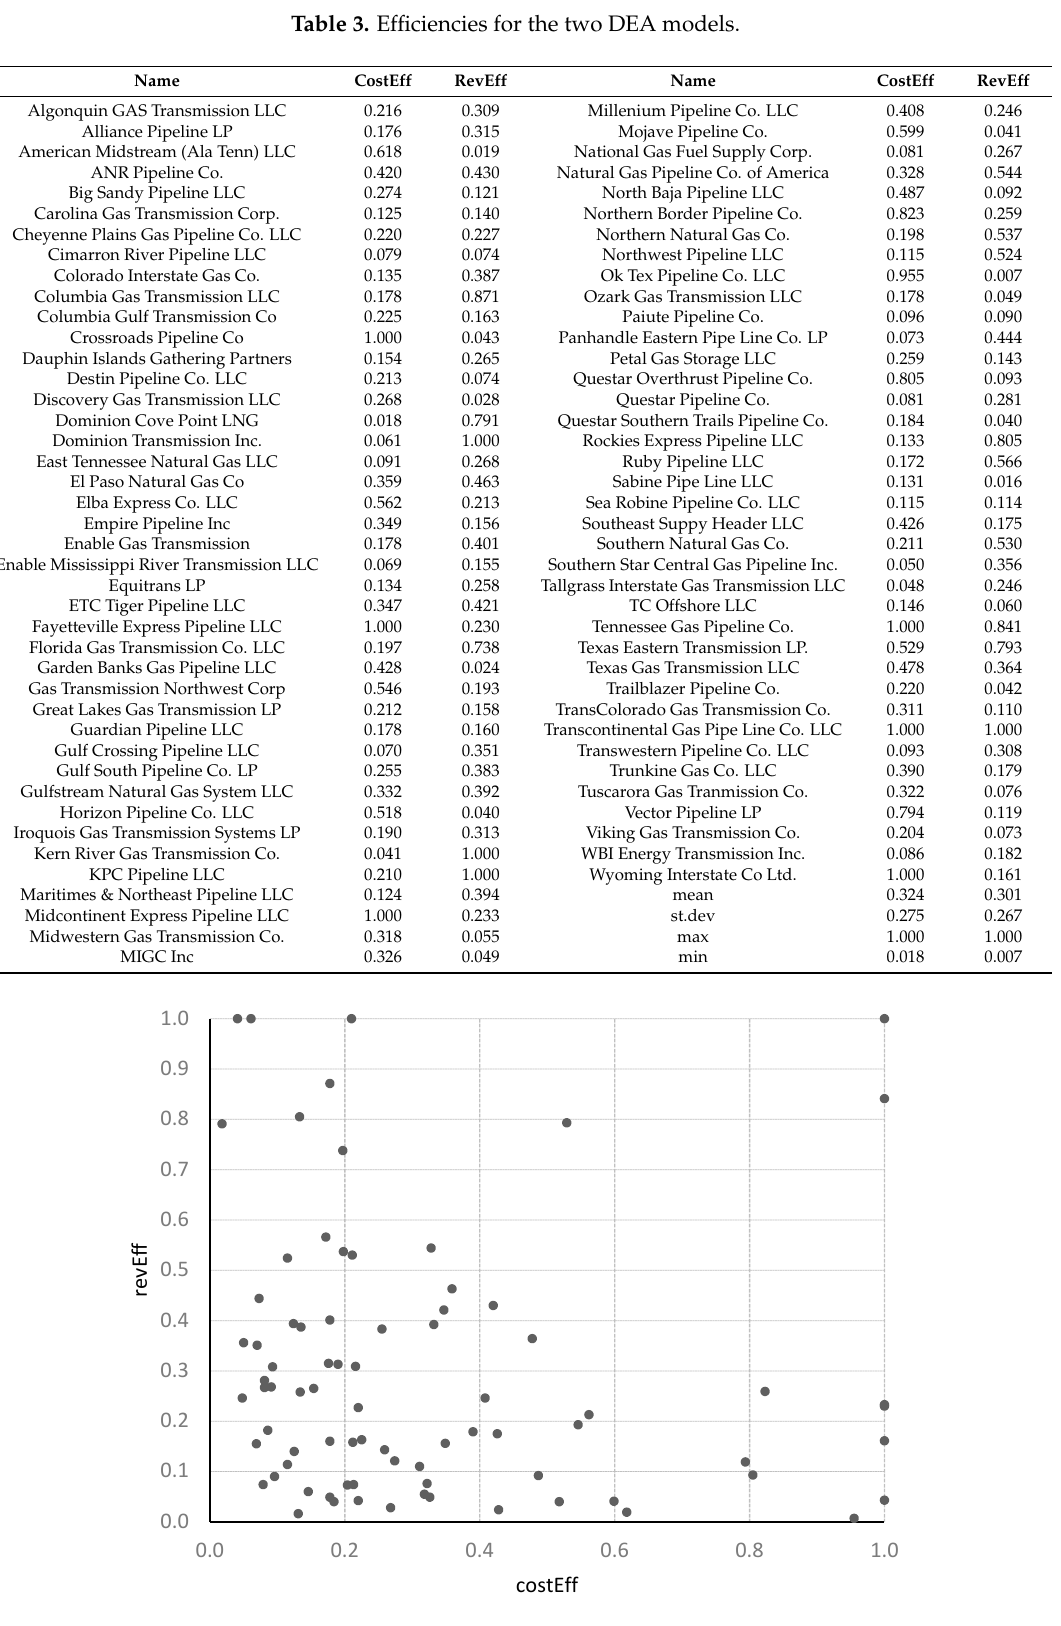
Figure 2. Plot of costEff and revEff scores.